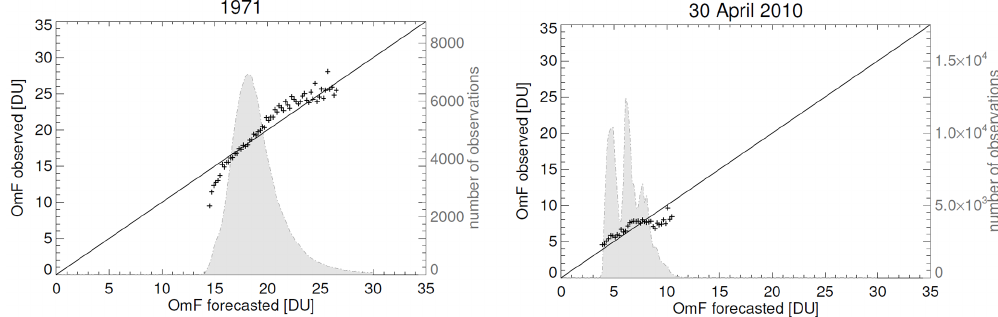
Figure 4. OmF (observation-minus-forecast) from the data assimilation as a function of the theoretical OmF as calculated from model error and the individual measurement errors. The grey area and y axis on the right indicate the number of observations per OmF value (bin size is